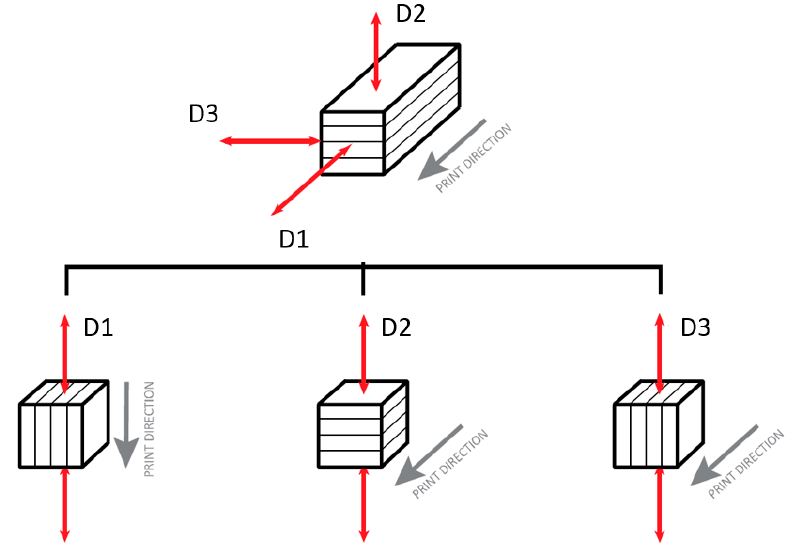
Figure 3. Schematic overview of testing directions for compression test.